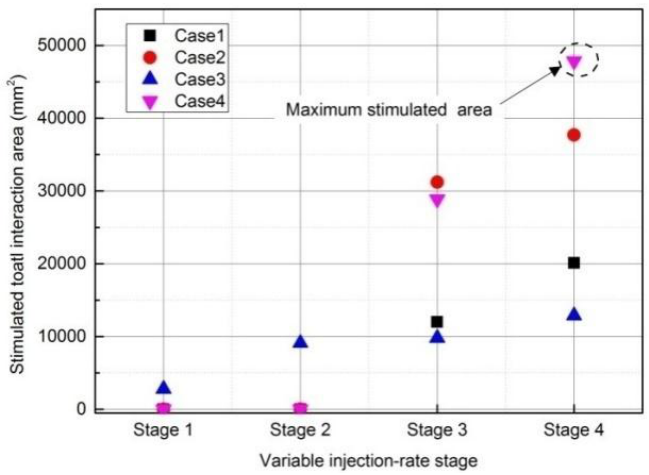
Figure 7. Comparison of total interaction area for different variable injection rate cases.